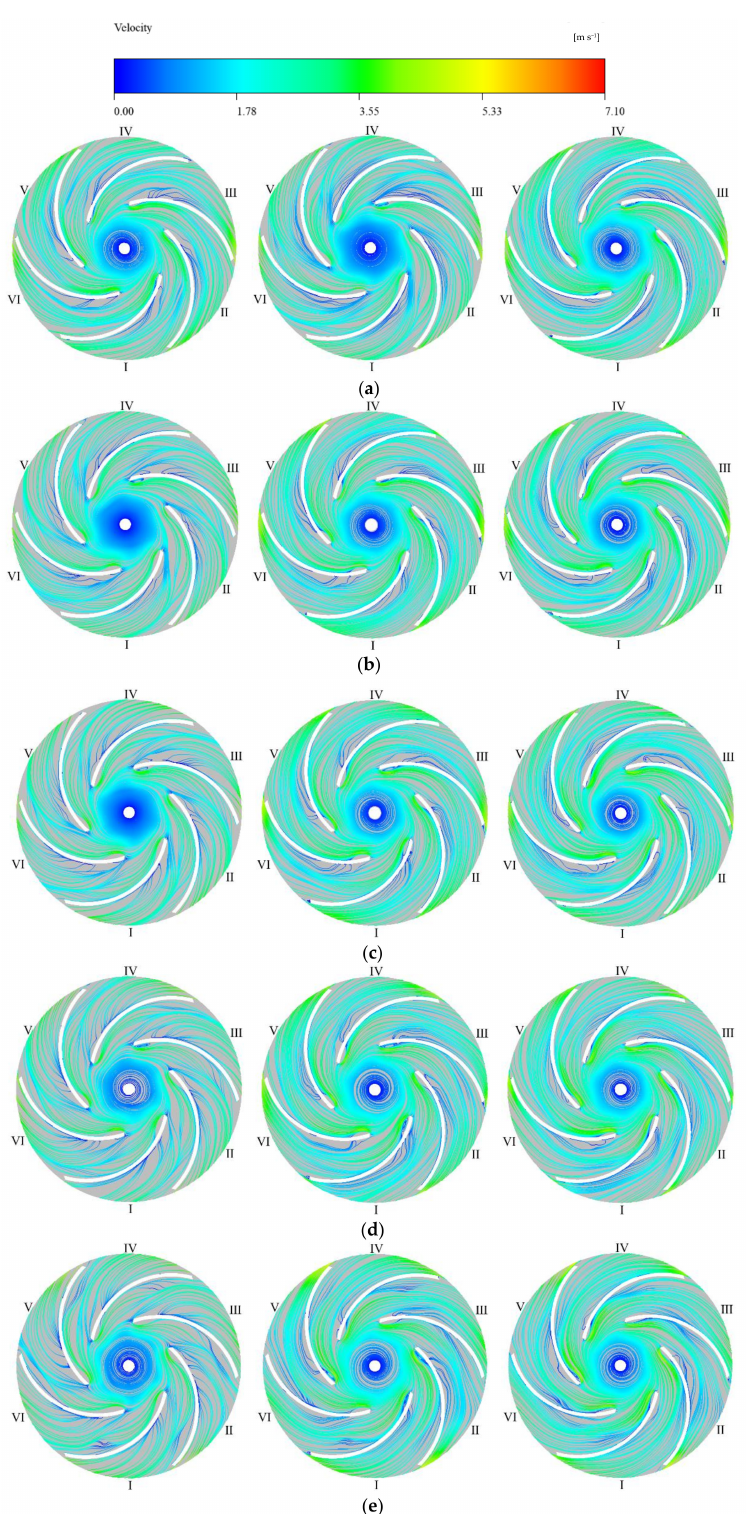
Figure 5. ( a – e ) Distribution of instantaneous streamlines for (from top to bottom): U rot /U ref = − 0.5, − 0.3, 0.0, 0.3 and 0.5. The left, middle and right columns represent the distributions on the cross- sections at Z/b 2 = 0.1. 0.5 and 0.9,